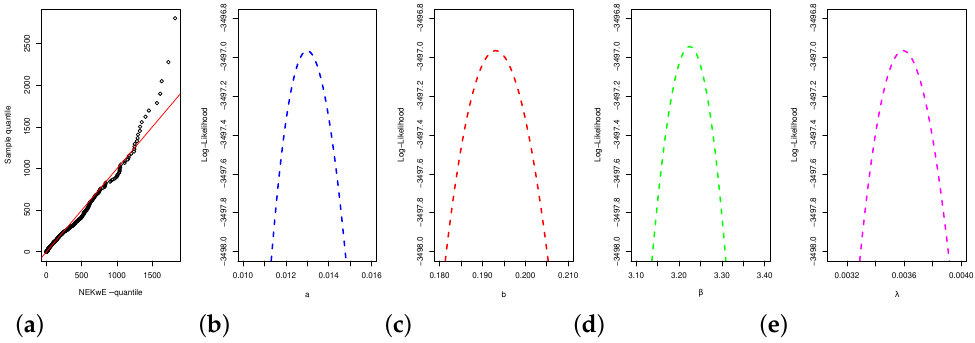
Figure 7. ( a ) QQ plot of the NEKwE model and ( b – e ): plots of the profile log-likelihood of the NEKwE model for the second data set, for a , b , β , and λ ,